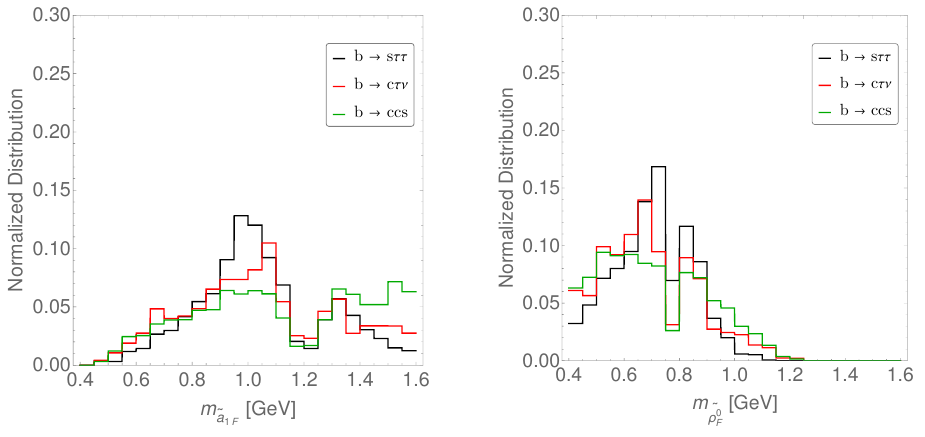
(left) and m (right) for the B 0 → K ∗ 0 τ + τ − measurement. ˜ ρ 0 1 F F ( ρ 0 ) in each event with its mass 1